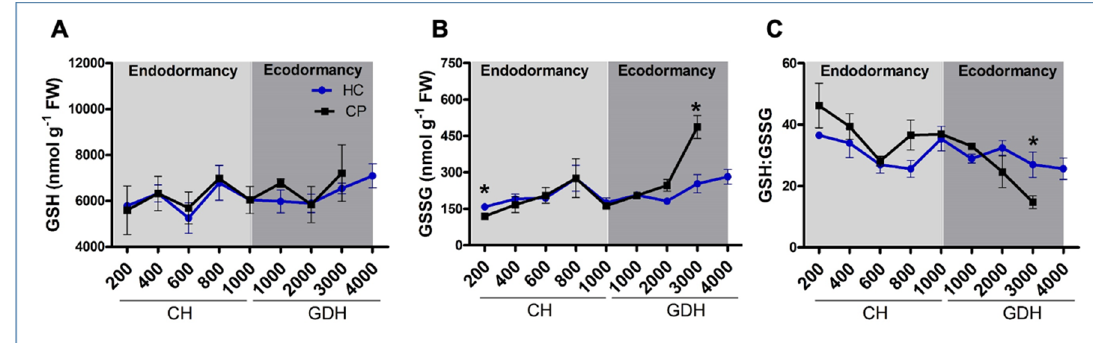
Figure 4. Changes in reduced glutathione, GSH ( A ), glutathione disulfide, GSSG ( B ) contents, and reduced to oxidized glutathione, GSH: GSSG ( C ) in two apple cultivars, ‘Honeycrisp’ (HC) and ‘Cripps Pink’ (CP) from the time of endodormancy induction to the bud break stage. Each point represents mean ± SEM of three biological replicates; p -value indicates comparison between ‘Honeycrisp’ and ‘Cripps Pink’ (* p < 0.05) using students t -test.